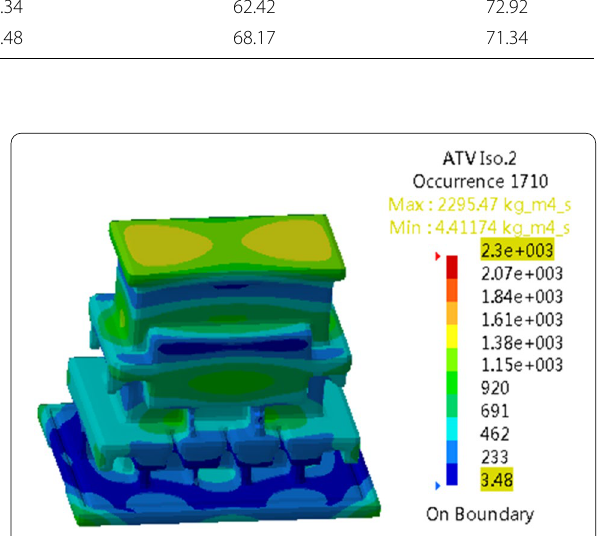
Figure 7 The distribution of ATV for field point 1 at 920